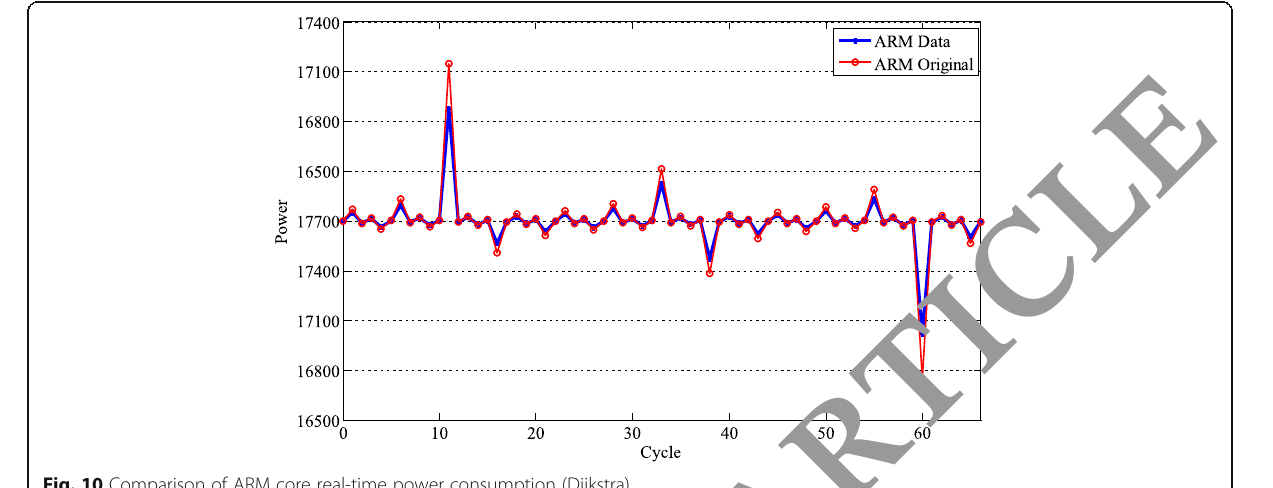
Fig. 10 Comparison of ARM core real-time power consumption (Dijkstra)